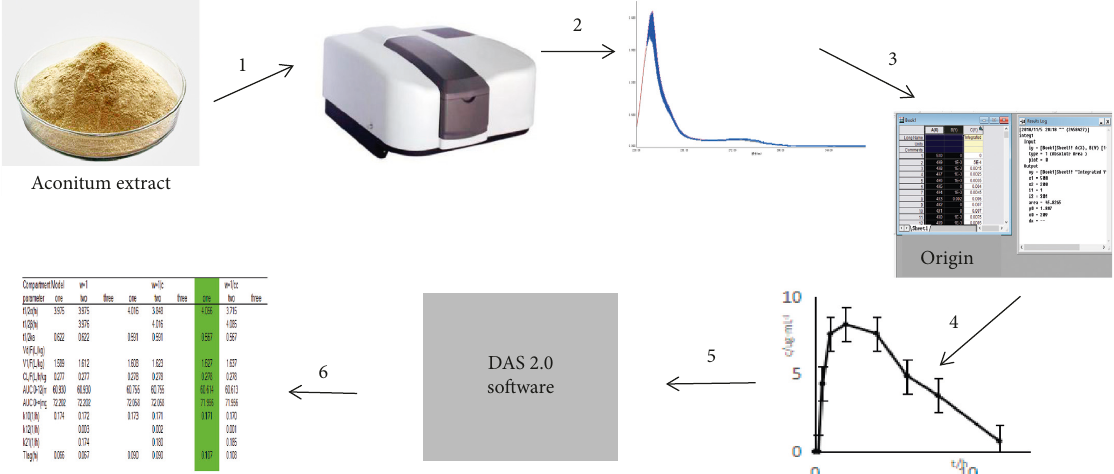
Figure 2: The in vivo analysis process of total components by the new method of AUAWC. (1) UV-Vis spectrophotometer for a full spectrum scanning; (2) exported .xl data files and preprocessed; (3) the data preprocessed are then exported into Origin software; (4) the value of AUAWC then were calculated; (5) the concentration acquired by the regression equation and kinetic time were analyzed by DAS 2.0 software; (6) the pharmacokinetic parameters and the concentration-time curves were